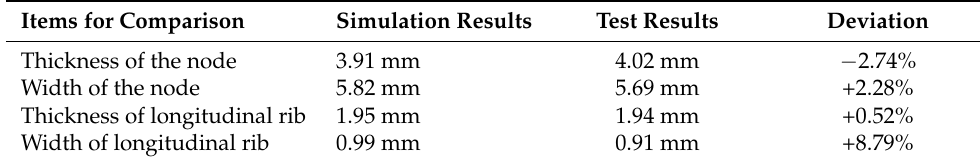
Table 2. Comparison of tensile forming simulation results with experimental data.